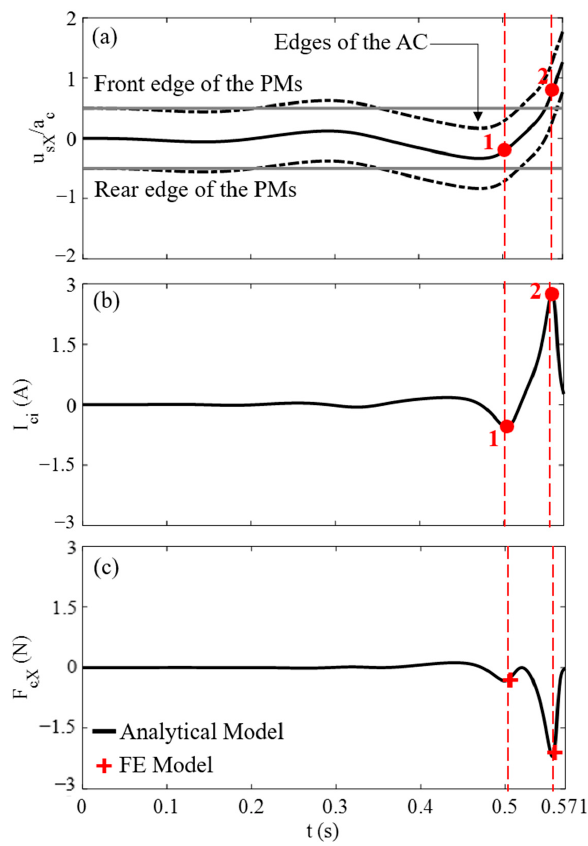
Figure 6. Comparison between the analytical model and the FE model to calculate the magnetic force; ( a ) displacement of the coil, ( b ) electric current induced in the coil, and ( c ) magnetic force acting on the coil.